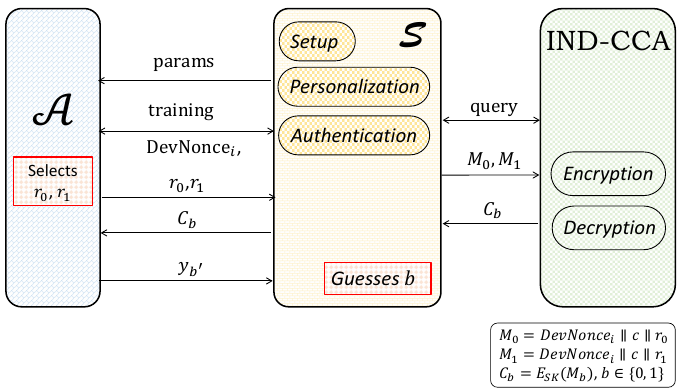
Figure 9. The security game among A , who can obtain the session key; S ; and IND-CCA